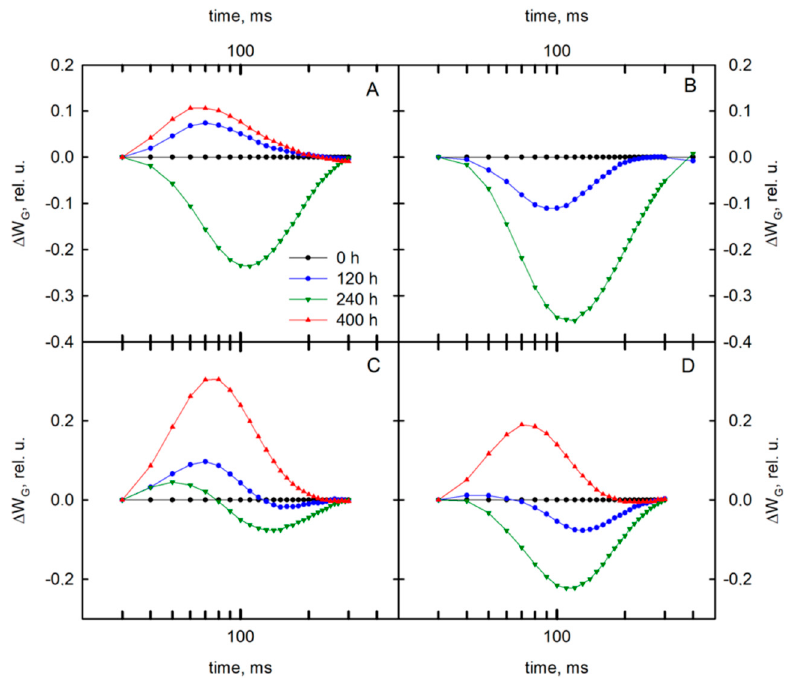
Figure A4. Differential curves of Δ W G (obtained by subtracting the control curve from the first sample in time from 30 to 1000 ms) of perennial ryegrass varieties (Roadrunner and Nira) under different field water capacity of soil (50 and 30% FWC) and time (0, 120, 240 and 400 h after stress application): ( A ) Roadrunner under 50% FWC, ( B ) Roadrunner under 30% FWC, ( C ) Nira under 50% FWC, ( D ) Nira under 30% FWC. n = 6. Relative units.